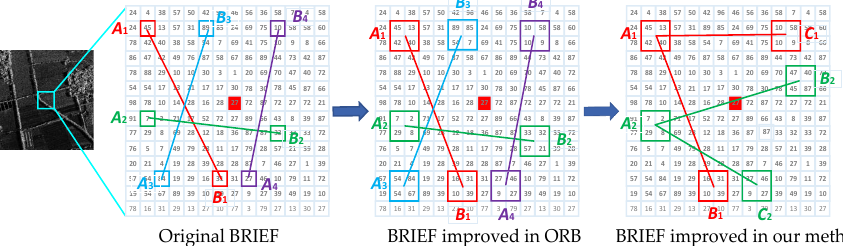
Figure 1. Gray value comparison modes of the BRIEF, ORB, and improved ORB.